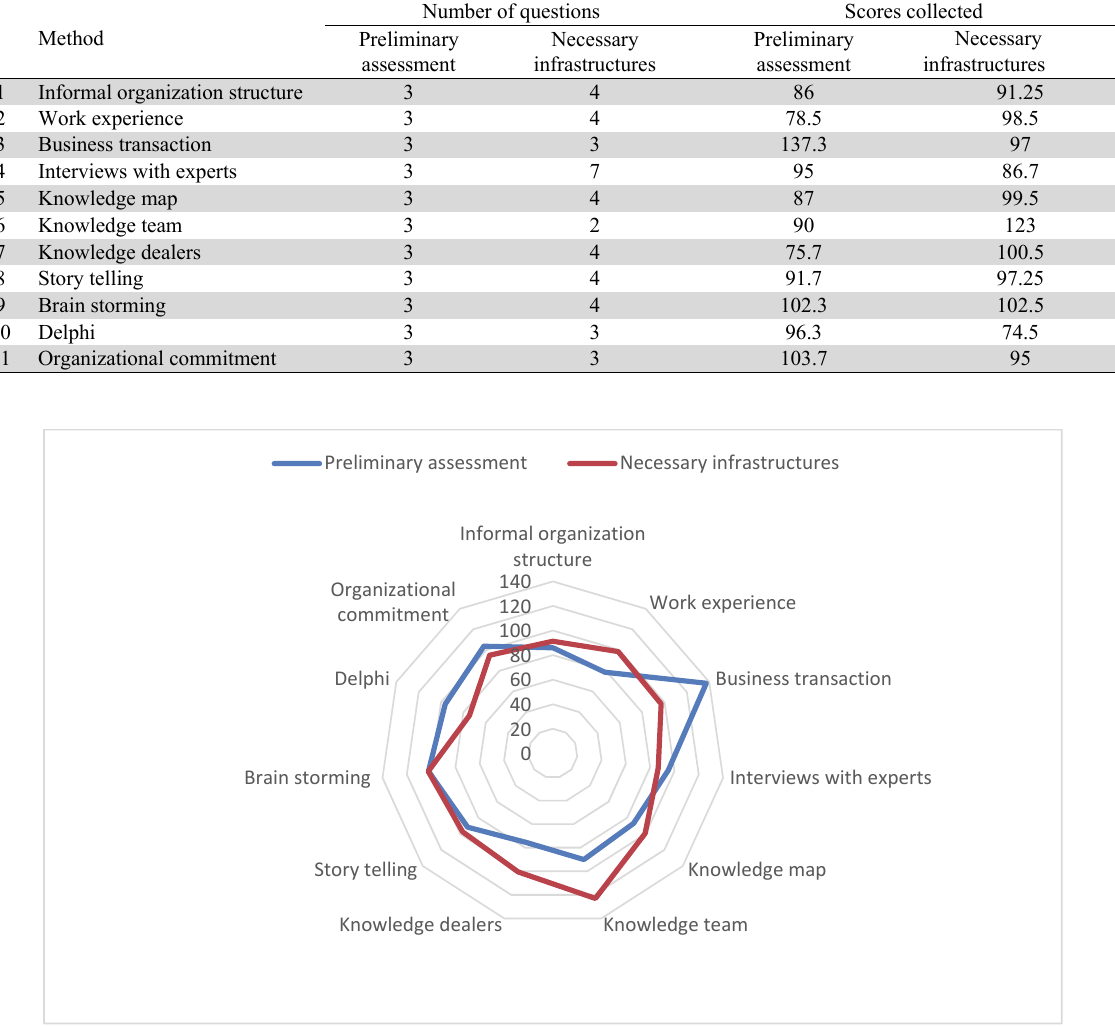
Fig. 2. The frequency of the scores assigned to preliminary and necessary assessment for knowledge creation and lessons